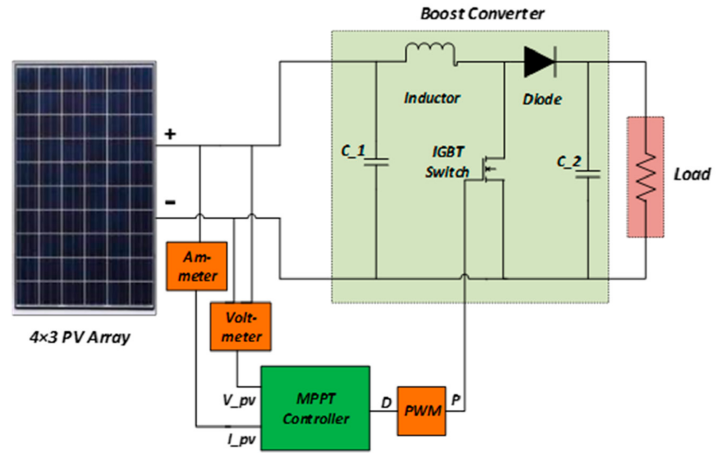
Figure 6. Schematic of proposed MPPT